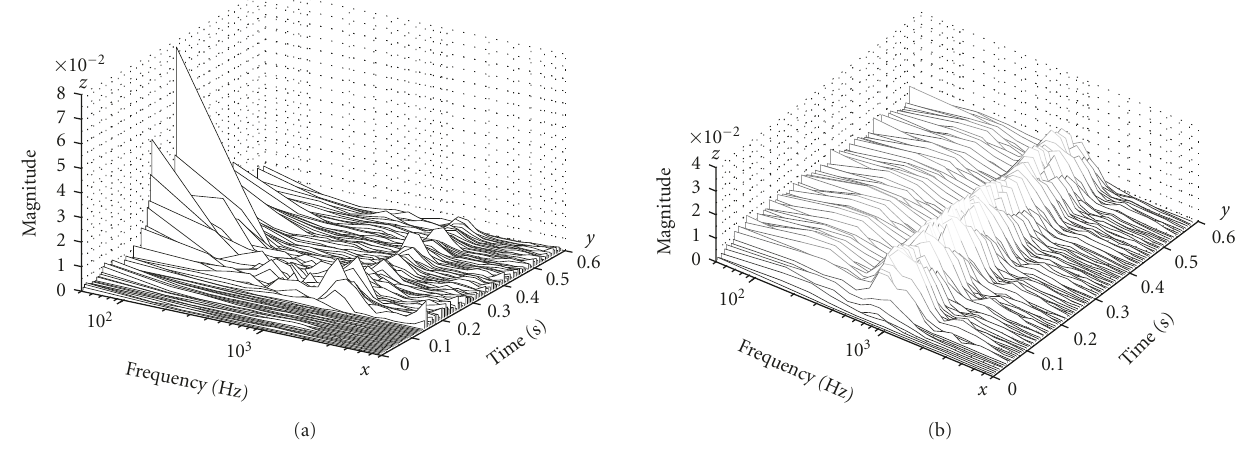
Figure 2: (a) CBT analysis of the first 600 ms of “ka”; (b) CBT analysis of the second 600 ms of “ka.”